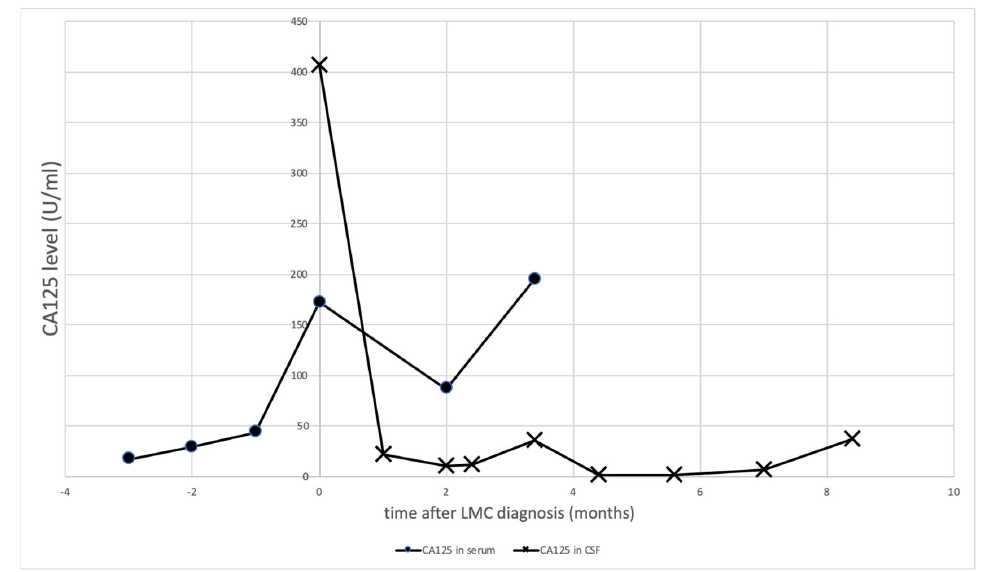
Figure 2. The serum and CSF level of CA125 indicating the controlled CSF lesion by intrathecal administration of MTX.